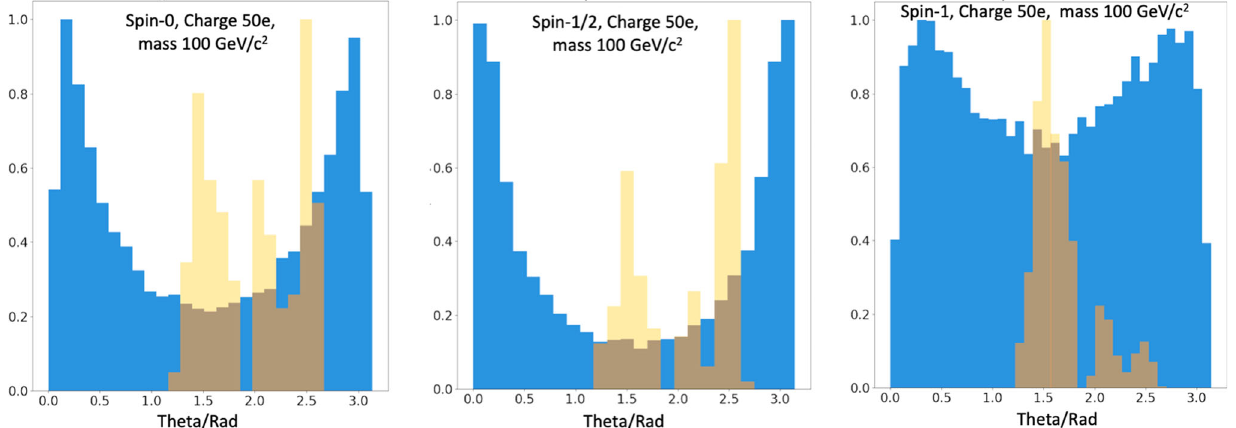
Fig. 16 The theta angle distribution for HECOs of mass 100 GeV/c 2 with electric charge 50 e produced via the DY process vias virtual pho- ton exchange, for each spin assignment. In each case, 60K events were